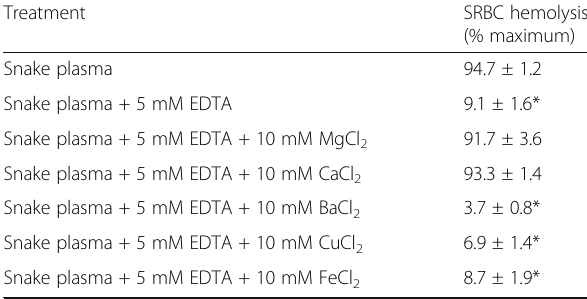
Table 2 Effects of divalent metal ions on the reconstitution of EDTA-inhibited sheep red blood cell (SRBC) hemolysis